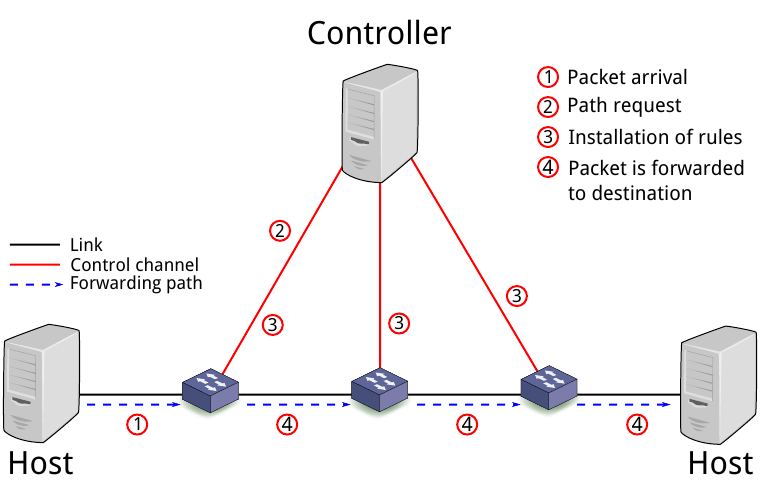
Figure 10. Reactive flow